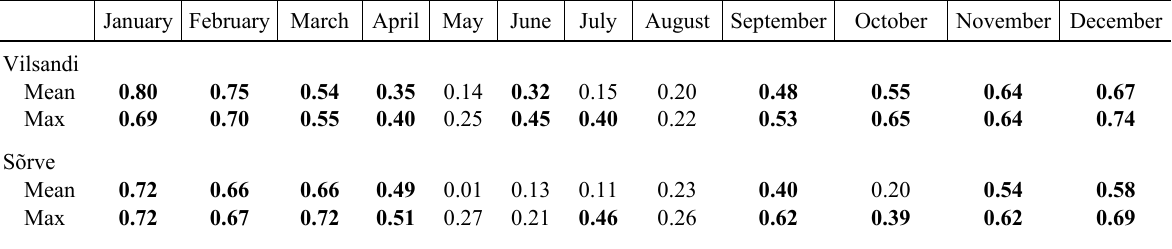
Table 3. Correlation coefficients between the monthly numbers of storm days at Vilsandi and Sırve, and monthly mean sea levels (upper values), and monthly maximum sea levels (lower values) for Estonia in 1966(cid:150)2011. Statistically significant correlations on the p < 0.05 level are typed in